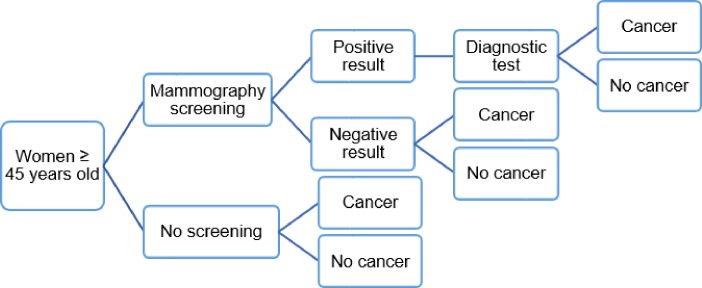
Decision tree model.